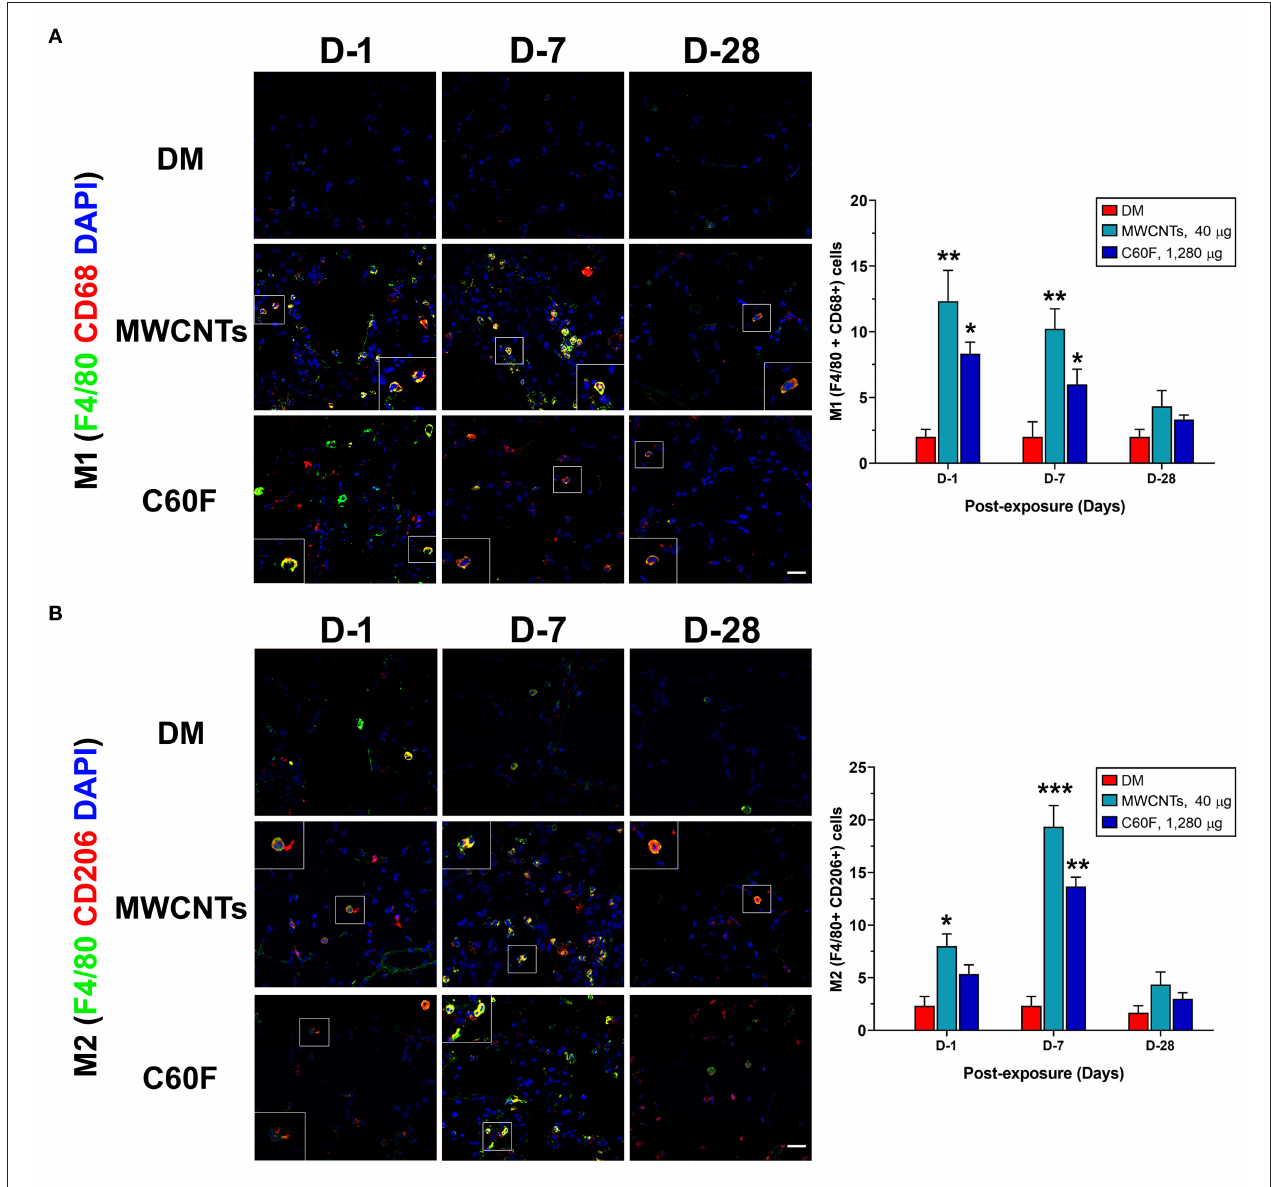
FIGURE 9 | M1-M2 polarization in lungs exposed to MWCNTs or C60F. Mice were treated as described in Figure 2 legend. M1 or M2 polarization of macrophages was examined by double immunofluorescence staining with anti-F4/80 (green) and anti-CD68 (red) antibodies (A) , or anti-F4/80 (green) and anti-CD206 (red) antibodies (B) in lung tissue. Numbers of representative double positive cells per 100 cells were counted from captured images and shown as mean ± SEM ( n = 3). Scale bar = 20 µ m. * p < 0.05; ** p < 0.01; *** p <